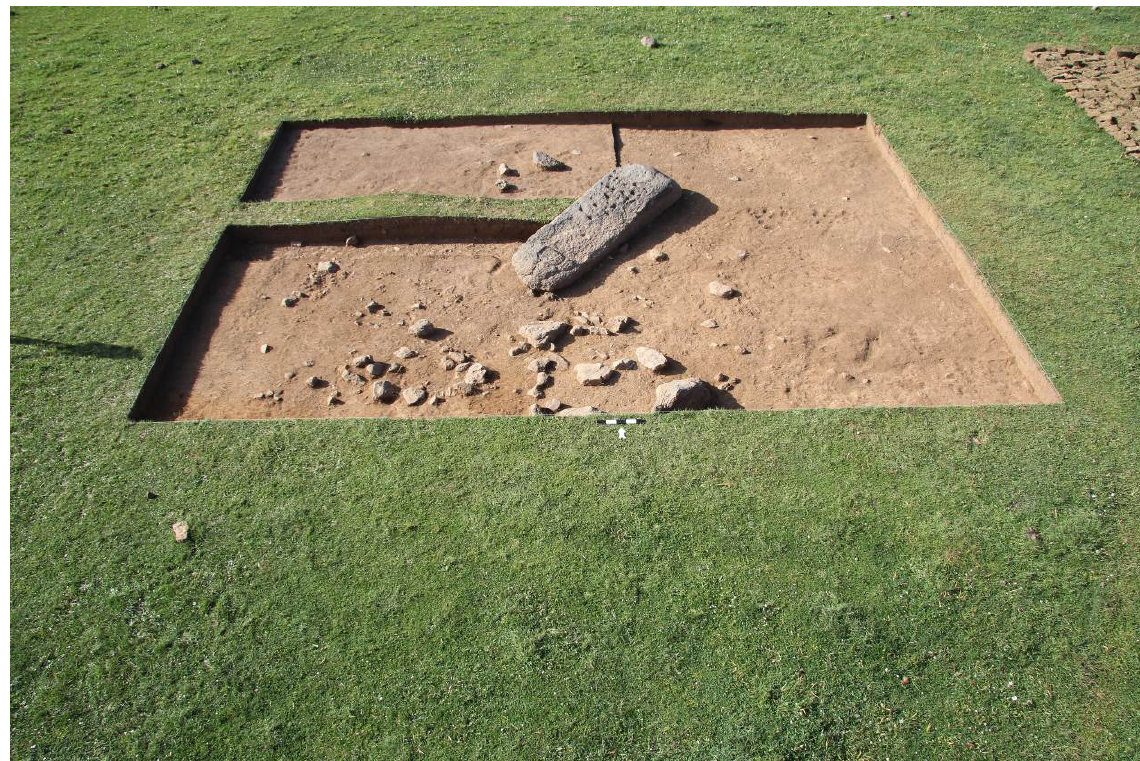
Figure 3. Fallen vishap covering its former construction pit in KS C, facing North. Note the secondary “cups” on the upper face (photo by P.